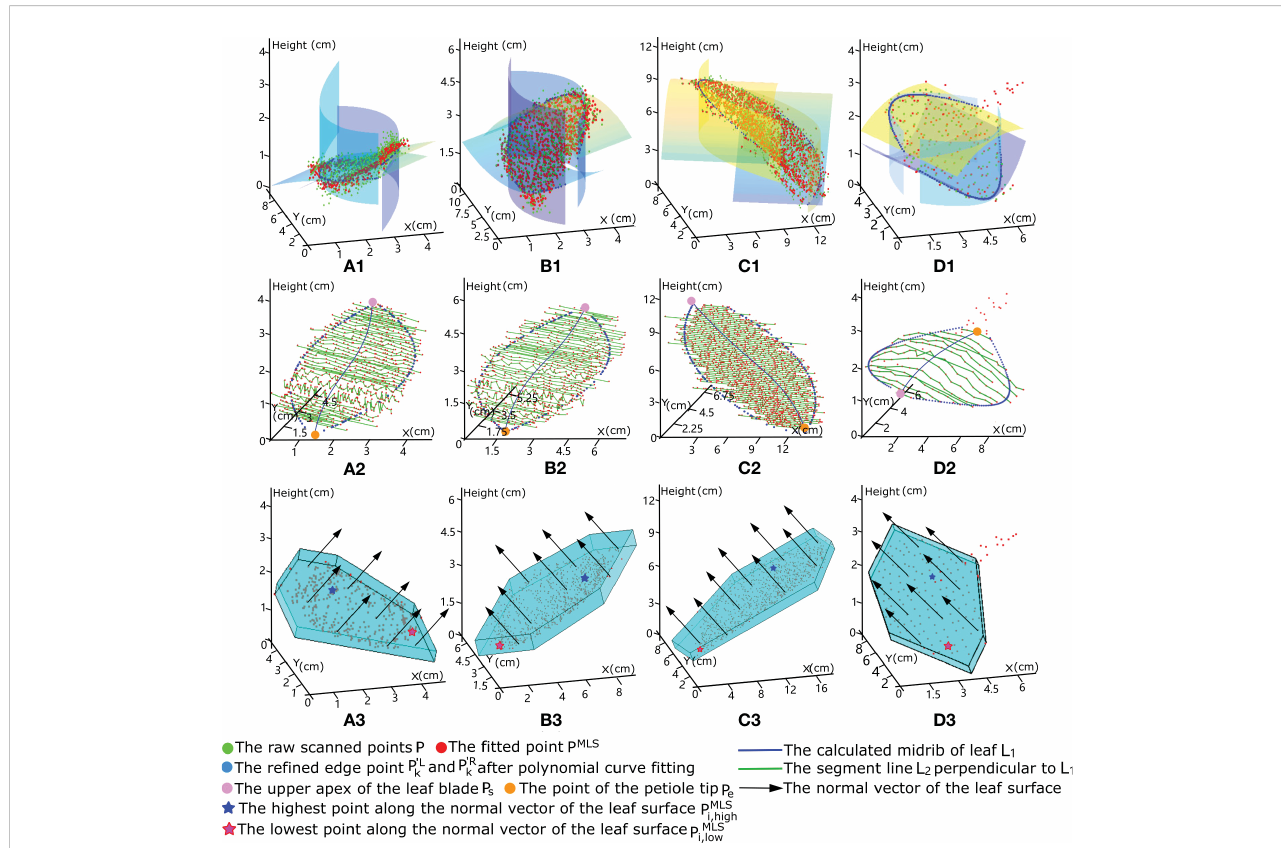
FIGURE 3 3D mock-up modelling process for certain leaves of different tree species using hexagonal prism envelopes to calculate the corresponding equivalent volume of each leaf blade. Each column shows the procedure of modelling a leaf of different tree species: (A) crepe myrtle leaf, (B) sakura tree, (C) magnolia leaf and (D) ginkgo leaf. The fi rst row shows that the raw scanned points, represented in green, are fi tted using moving least squares for noise removal and surface smoothing, with the fi tted results represented by the red points. The second row shows that the leaf surface was divided into many segments according to green line L 2 perpendicular to leaf midrib L 1 , as shown by the blue line. The edge points of each segment on both sides re fi ned using polynomial curve fi tting are shown in blue. The third row shows that the constructed hexagonal prism envelope is modelled according to the re fi ned edge points, with its height equal to the distance between the highest and the lowest fi tted leaf points along the normal vector of the leaf